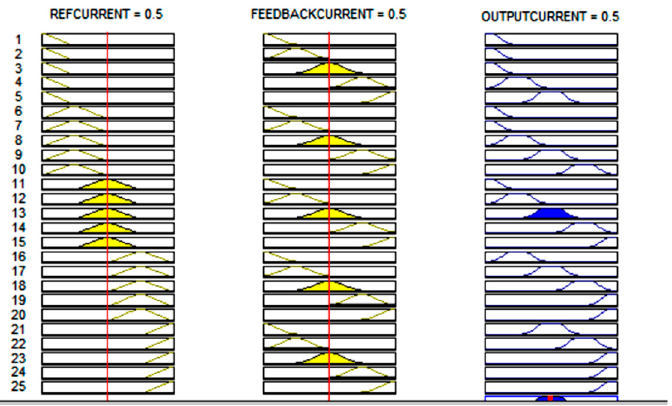
Figure 24. Rule viewer plot for Rule 4.